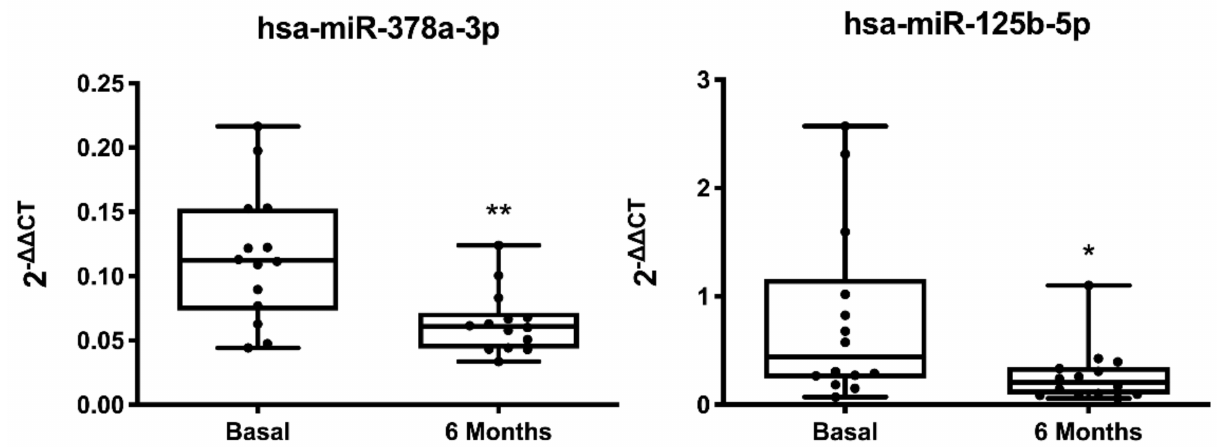
Figure 3. Differential follow-up expression of miRNAs in responders. Box-and-whiskers min to max plots showing plasma levels of microRNAs. Data correspond to differentially expressed miRNAs in responder patients ( n = 14). * p < 0.05 and ** p < 0.01 basal vs. 6